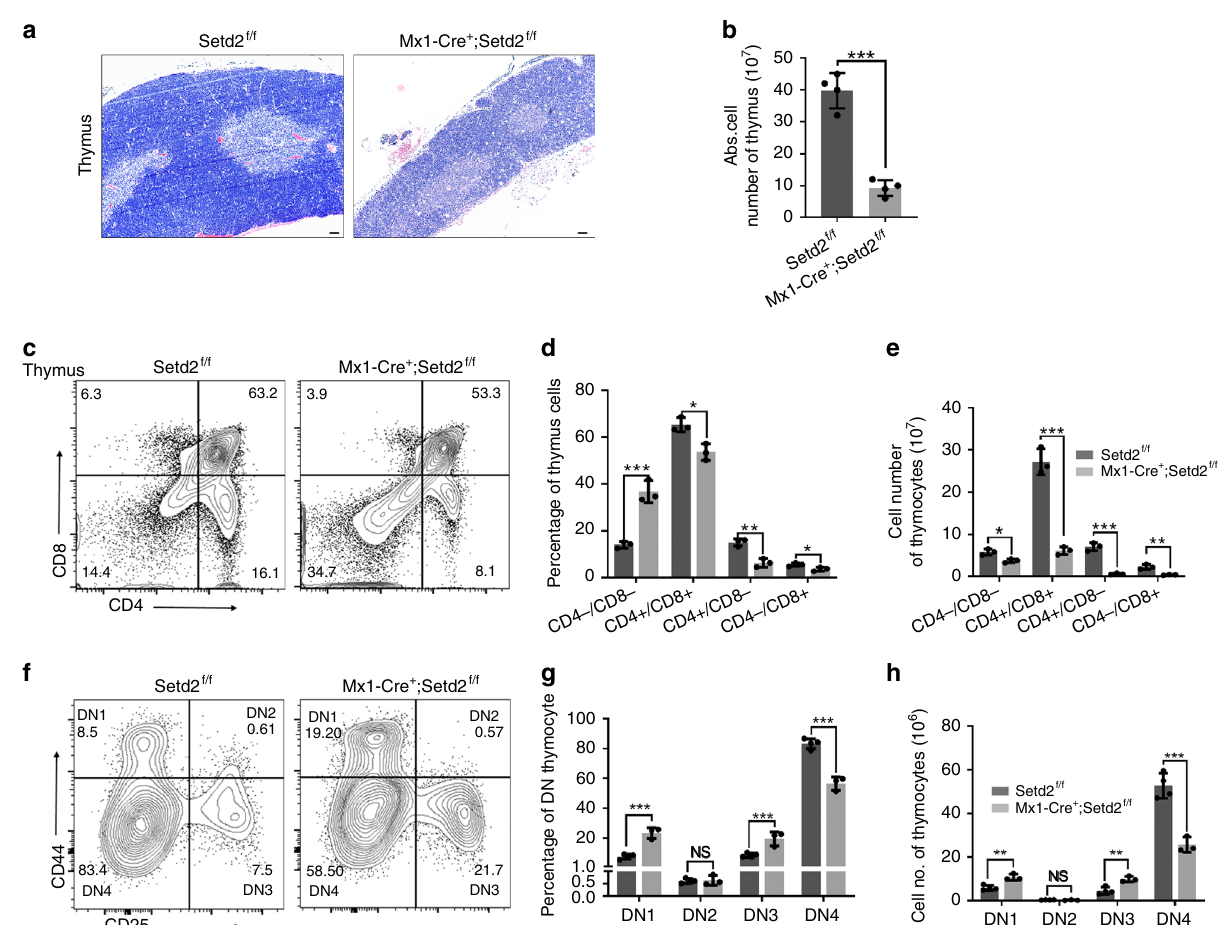
Fig. 3 T cell development is blocked at the DN3 stage in Mx1-Cre + ;Setd2 f/f mice. a Representative hematoxylin – eosin (H&E) staining of thymus sections from Setd2-de fi cient and control mice (scale bar = 50 μ m). b Total thymic cell number in Setd2-de fi cient mice and control mice ( n = 8). c – e Representative fl ow cytometry plots of anti-CD4 and anti-CD8 antibody staining in thymocytes ( c ) and the frequency ( d ) and cell numbers ( e ) of subpopulations of thymocytes from Setd2-null and control mice after pIpC treatment ( n = 6). f – h Flow cytometric analysis showing subpopulations of double-negative, DN1 (CD44 + CD25 − ), DN2 (CD44 + CD25 + ), DN3 (CD44 − CD25 + ), and DN4 (CD44 − CD25 − ) thymocytes from Setd2-de fi cient and control mice ( n = 6). (The data are presented as the means± SDs. * p < 0.05; ** p < 0.01; *** p < 0.001; ns, not signi fi cant, Source data are provided as a Source Data fi H3K36me3 histone methyltransferase, we hypothesized that H3K36me3 might be required for V(D)J rearrangement. To test